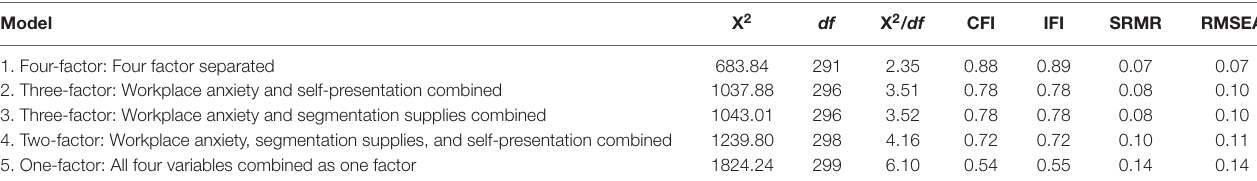
TABLE 2 | Results of confirmatory factor analysis of the study variables.